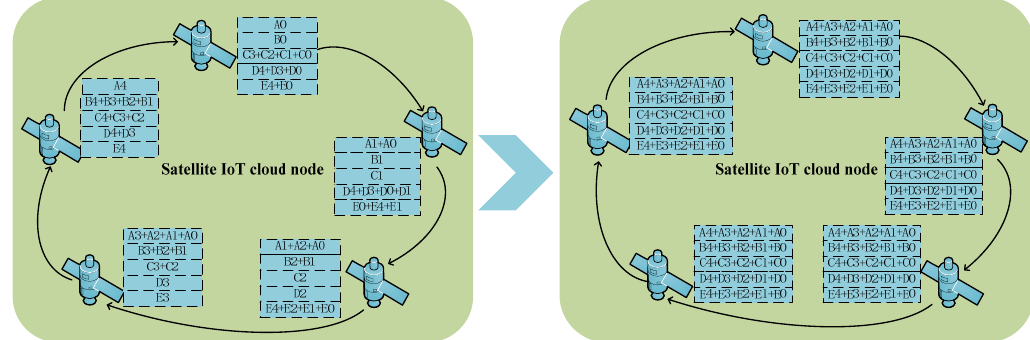
Figure 4. Training-inference-isolated satellite IoT edge intelligent computing architecture’s neural network training process.